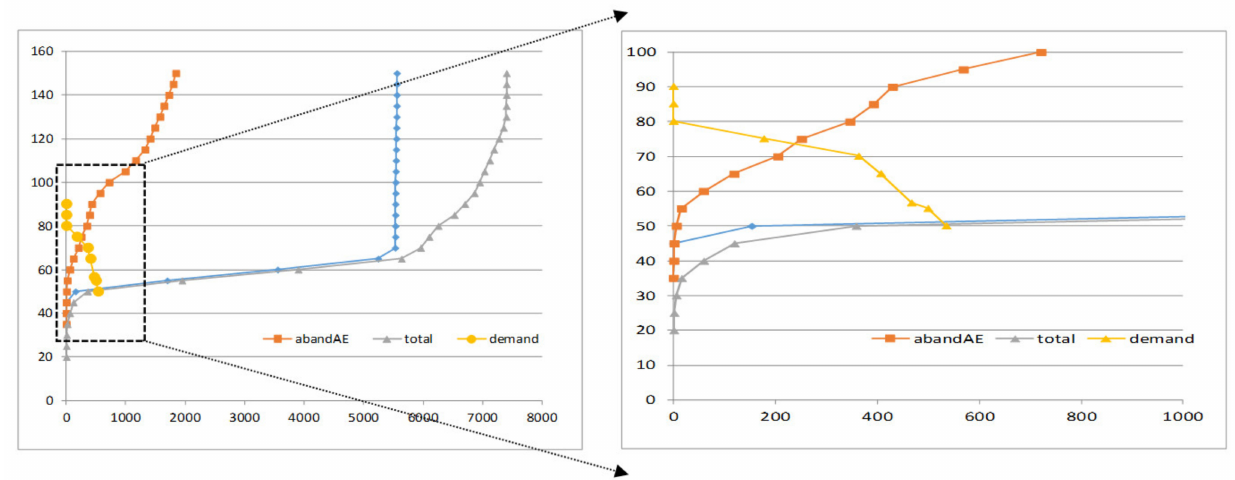
Figure 5. Aggregate demand and supply (the right graph is a detailed version of the left one). Vertical axis in € /t, horizontal axis in